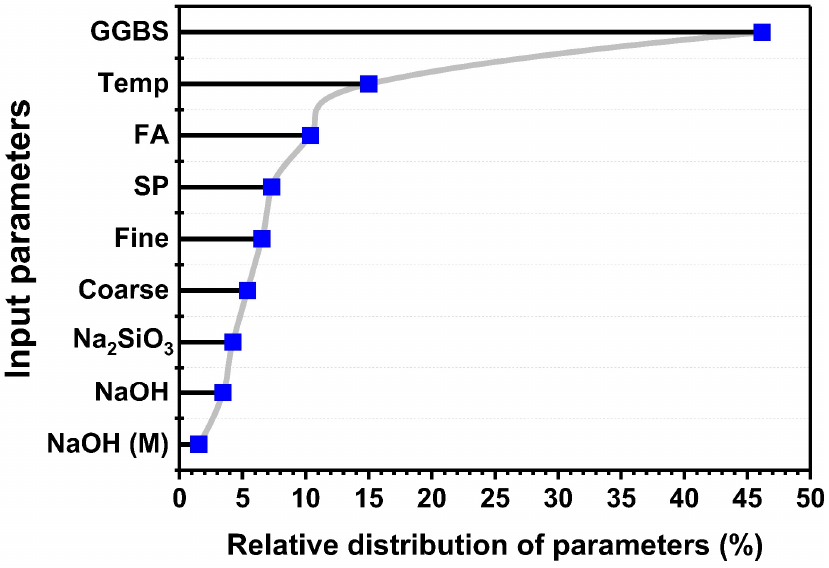
Figure 9. Permutation analysis of parameters in geopolymer concrete (GPC).